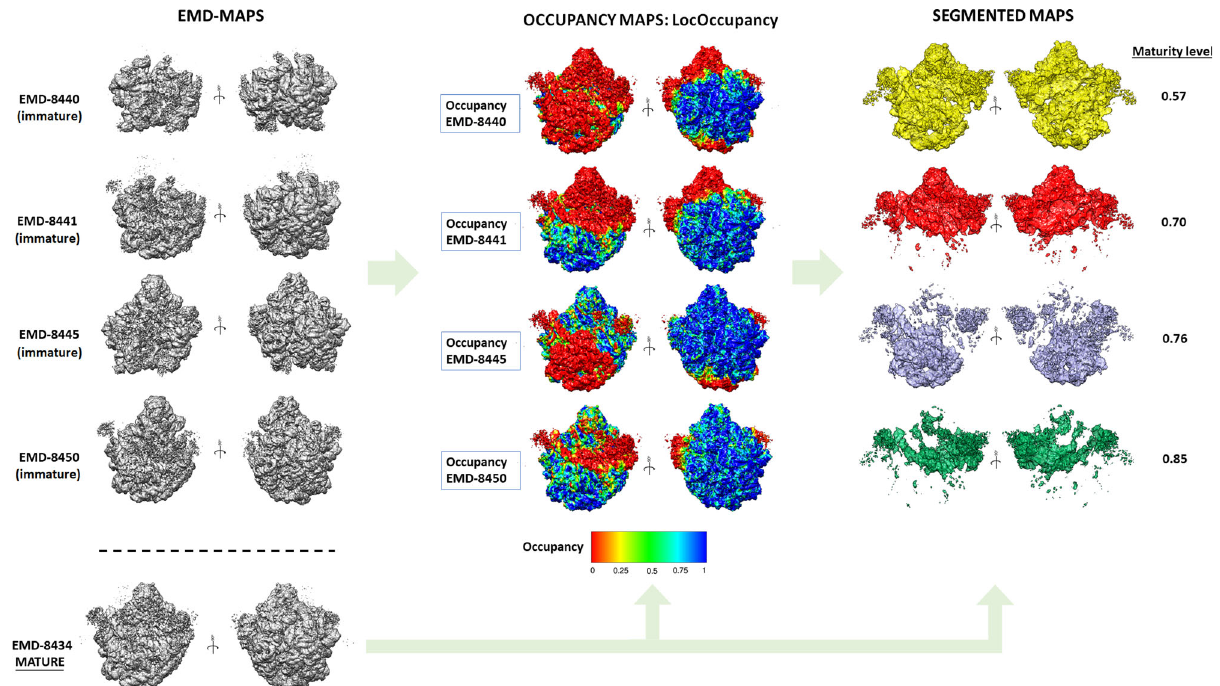
Fig. 4 Results obtained by LocOccupancy for immature 50S ribosomes. First column: immature maps at different orientations as deposited in EMDB. Second column: obtained occupancy maps by LocOccupancy, where the mature 50S ribosome (EMDB-8434) is coloured with corresponding occupancy maps obtained from the immature ribosomes. The occupancy ranges between [0, 1]. Third column: Segmented maps showing the densities that are missing in the different immature maps when compared to the mature 50S reconstruction and obtained maturity levels. The different colours (yellow, red, purple, green) label the different corresponding segmented regions for each